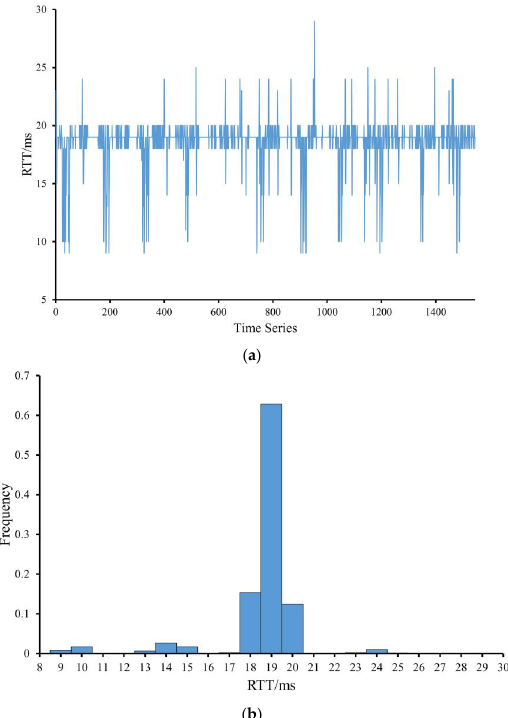
Figure 2. RTT measurement results ( a ) Timing diagram; ( b ) RTT distribution histogram.